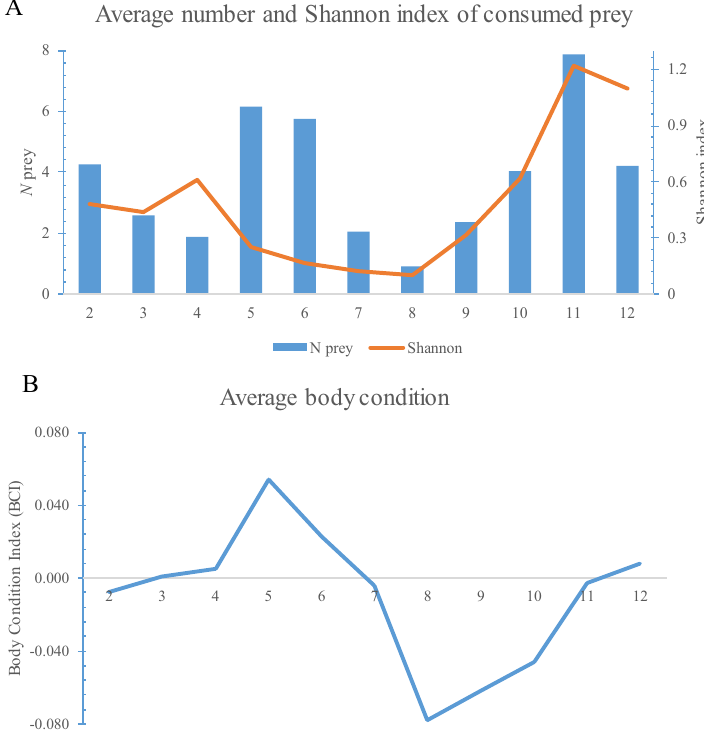
Figure 4. ( A ) Average number and the diversity (Shannon index) of consumed prey in the six populations of Speleomantes italicus . ( B ) Annual variation of body condition index (BCI) for the same populations. Numbers on x axis indicate the months; January is not included as no salamanders were